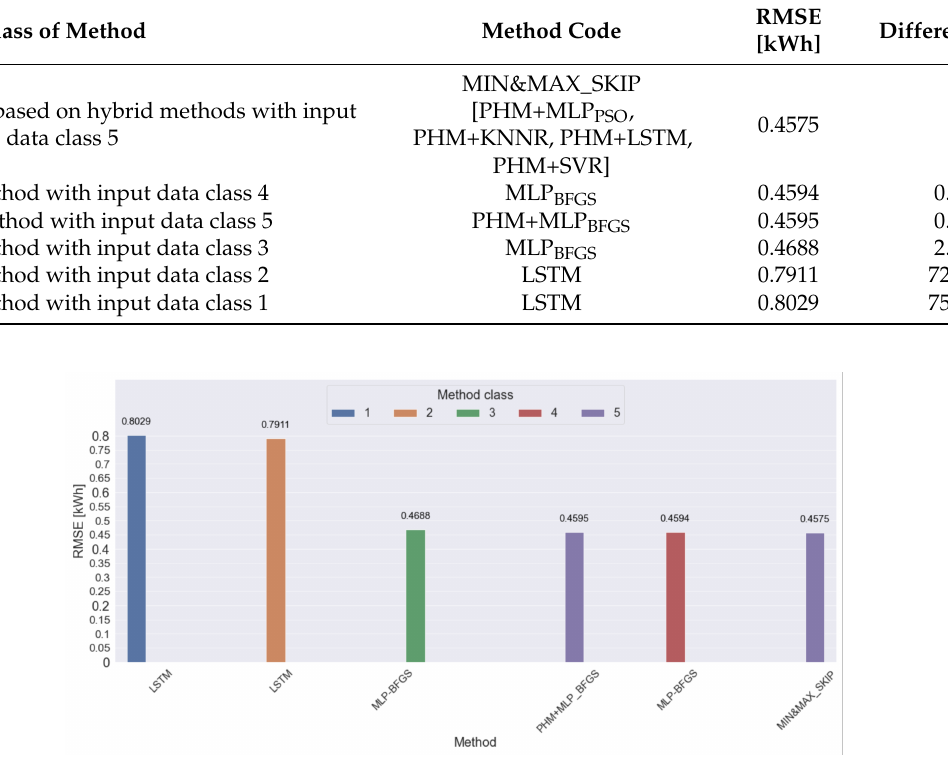
Figure 13. Collective set of best results with respect to MAE for each class of